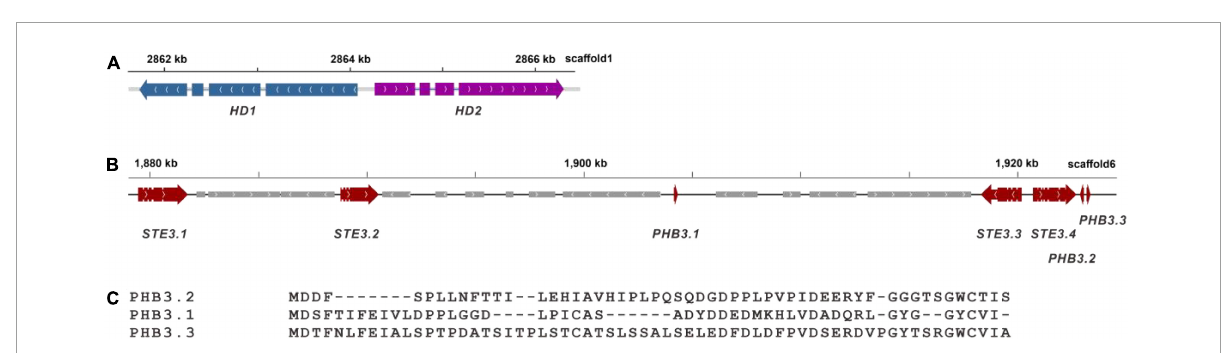
FIGURE7 Gene structure of the mating type locus of P. giganteus . (A) Structure of A mating type locus in P. giganteus . (B) Structure of B mating type locus in P. giganteus zhudugu2 . (C) Comparison of the mating pheromones predicted in P. giganteus